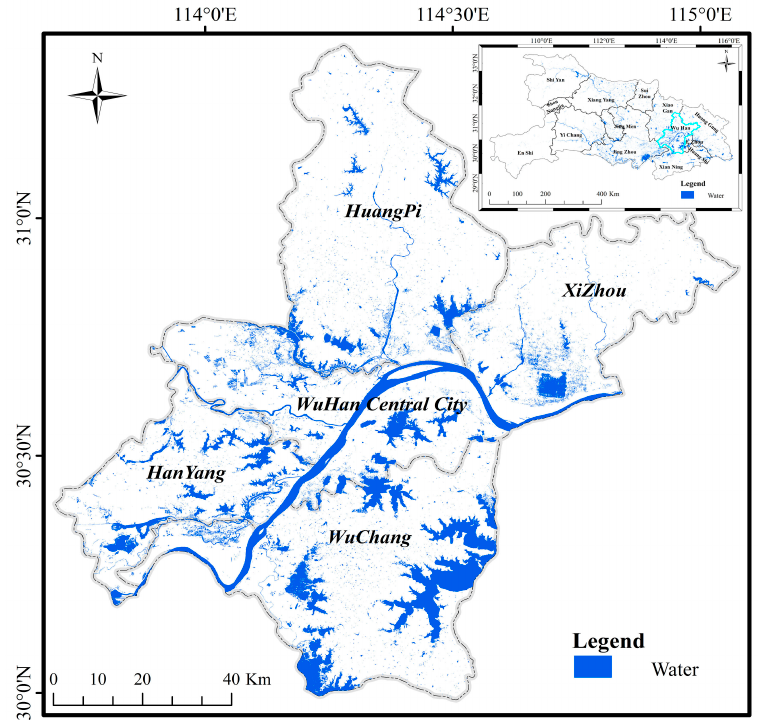
Figure 4. Location of the study area.